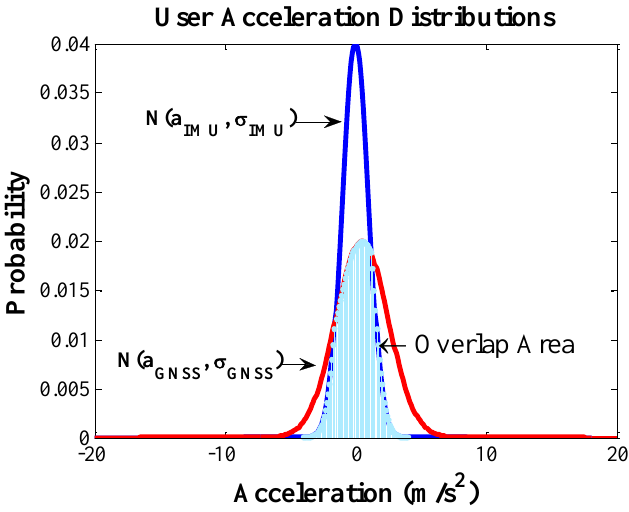
Figure 2. Consistency between